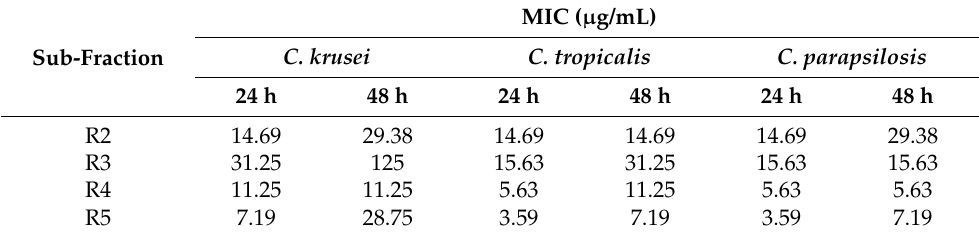
Table 6. MIC values (µg/mL) of the sub-fractions R2 to R5 for C. krusei , C. tropicalis and C. parapsilosis.